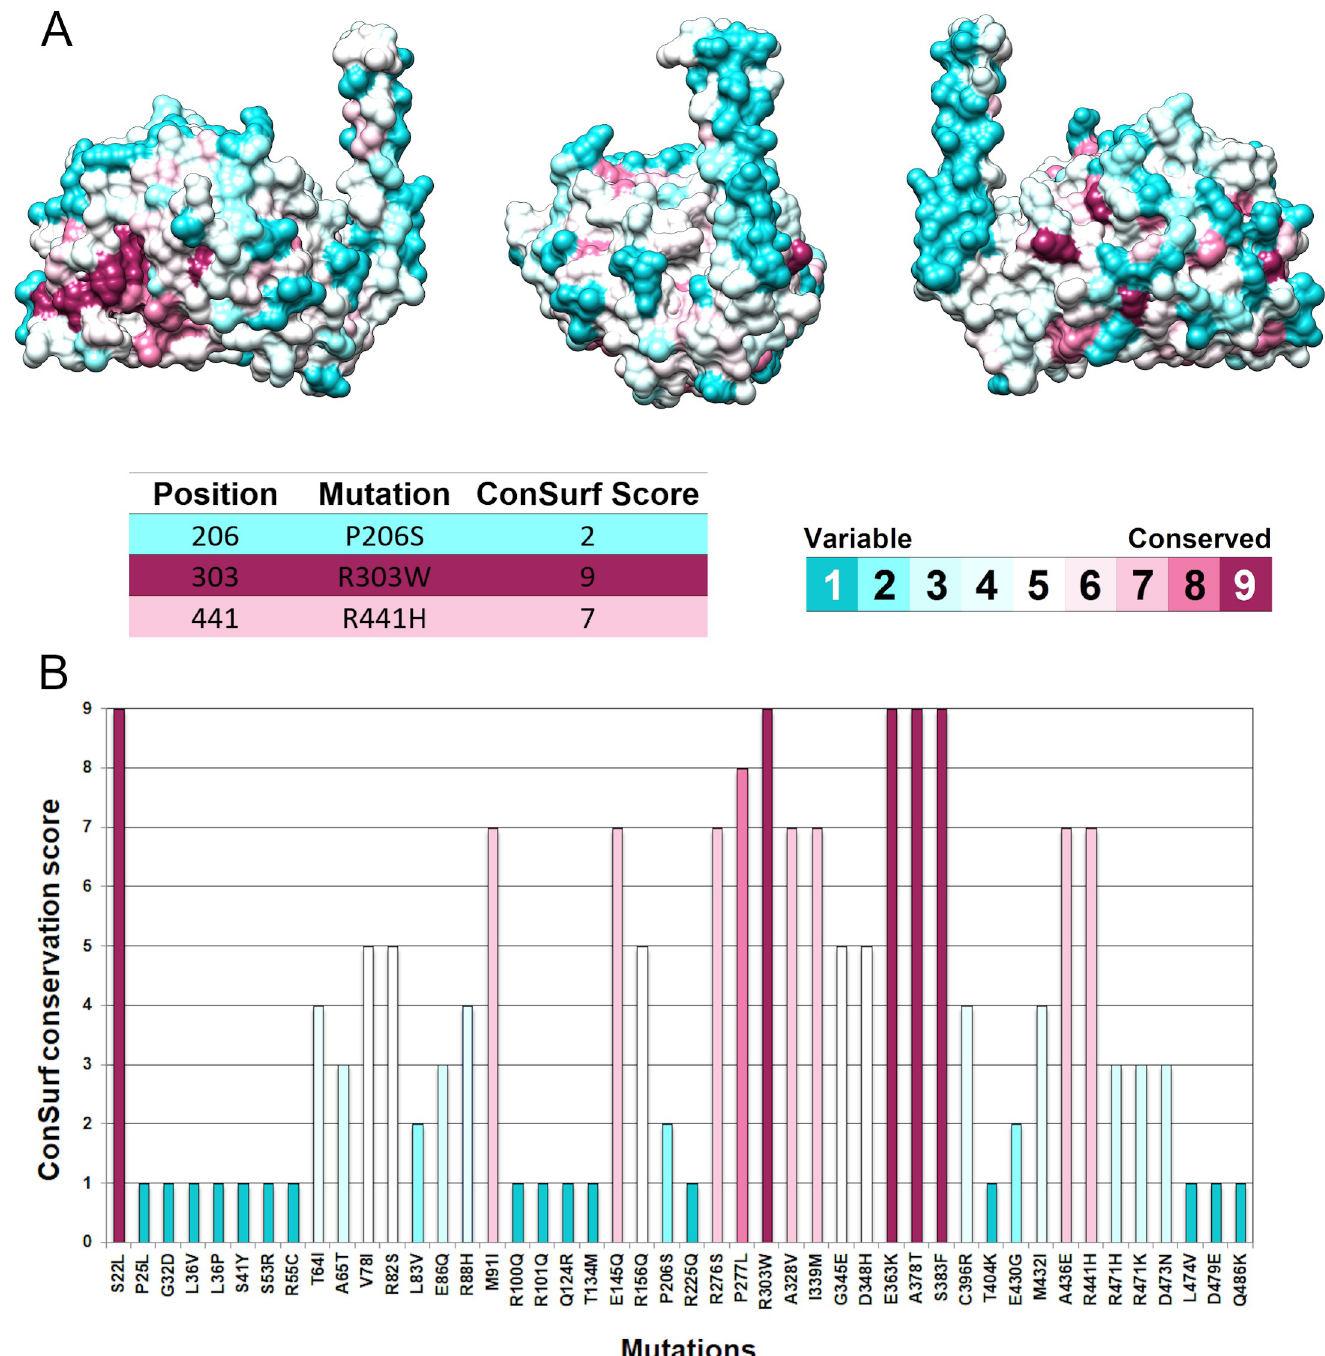
Fig 3. Evolutionary conservation analysis of TPH2 protein. (A) The evolutionary conservation profile of the TPH2 protein is shown at three different angles. Each amino acid of TPH2 is represented as a space-filling model and colored according to its ConSurf conservation score. The color-coding bar shows the ConSurf coloring scheme, which varies from cyan and highly variable to maroon and highly conserved. The conservation score for each amino acid of TPH2 affected by deleterious mutations, i.e., P206S, R303W, and R441H, are also shown. (B) The bar plot shows the ConSurf score for each amino acid of TPH2 affected by mutations. The bar plot was colored according to the ConSurf coloring